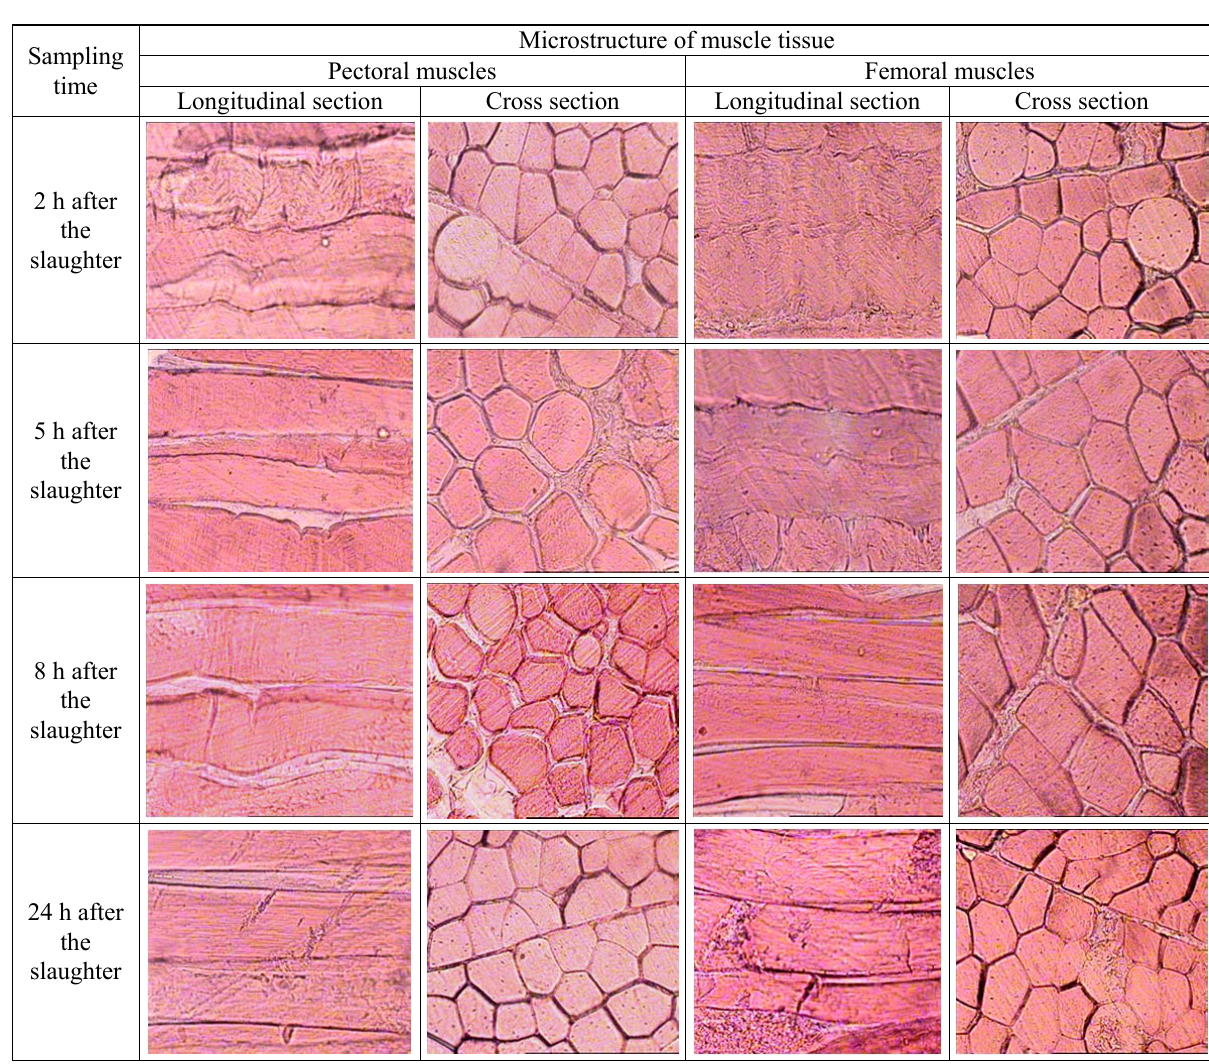
Table 2. Microstructure of the muscular tissue of turkey meat at different stages of autolysis with its history close to